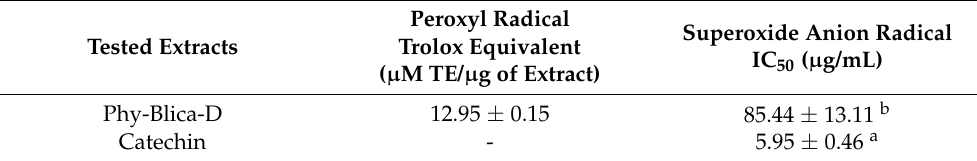
Table 3. Peroxyl and superoxide anion radical scavenging properties of Phy-Blica-D.